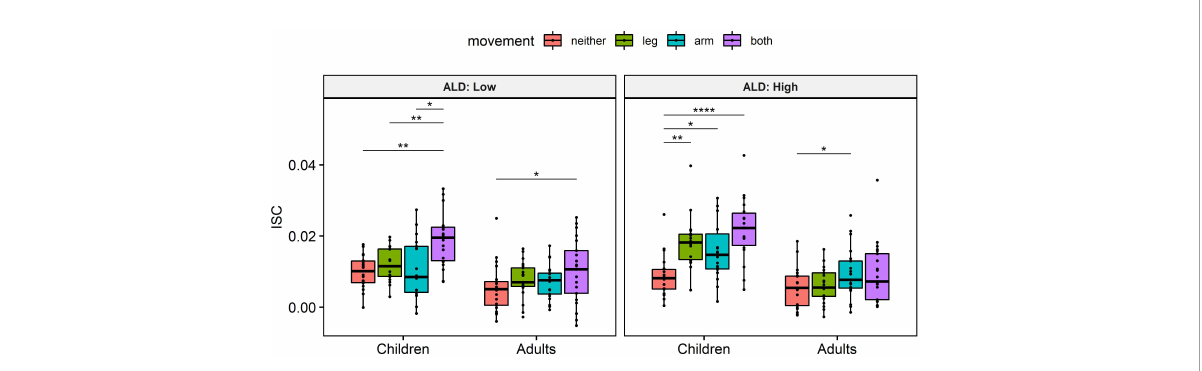
FIGURE2 Average intersubject correlation (ISC) by movement, Age group and Average luminance difference (ALD) levels. Data from all 4 video stimuli were included in the analysis. Due to the problem of p -values associated with large samples (Lin et al., 2013), we first averaged the data of each participant and only then applied pairwise one-sample Wilcoxon tests, in order to limit the probability of Type I error. Wilcoxon tests were preferred over t -tests due to the non-normal distribution of the data (as assessed by Shapiro–Wilk test, p < 0.05). Hence, individual points in the plot correspond to individual subjects (sum of 3 strongest components). P -values were corrected for multiple comparisons, using Bonferroni correction. * p < 0.05, ** p < 0.01, and **** p <